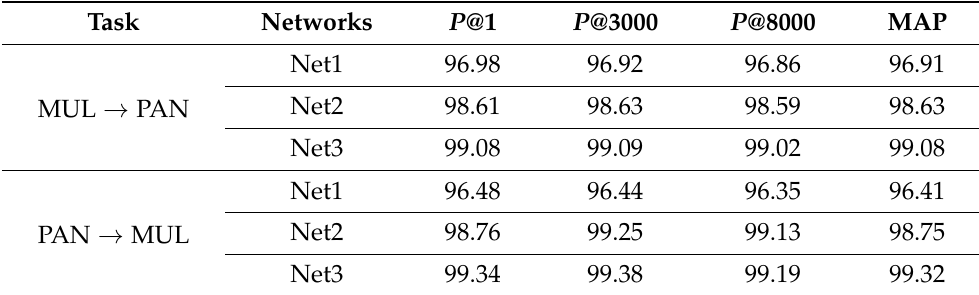
Figure 6. Visual retrieval results on cross-source PAN → MUL. Inquiry images in the first row are from a panchromatic source and they are picked from each class respectively. ( a – h ) are retrieved images for the corresponding inquiry images in the first row. The red rectangles denote the false retrieved images that are irrelevant to inquiry images. Table 4. Performance of different